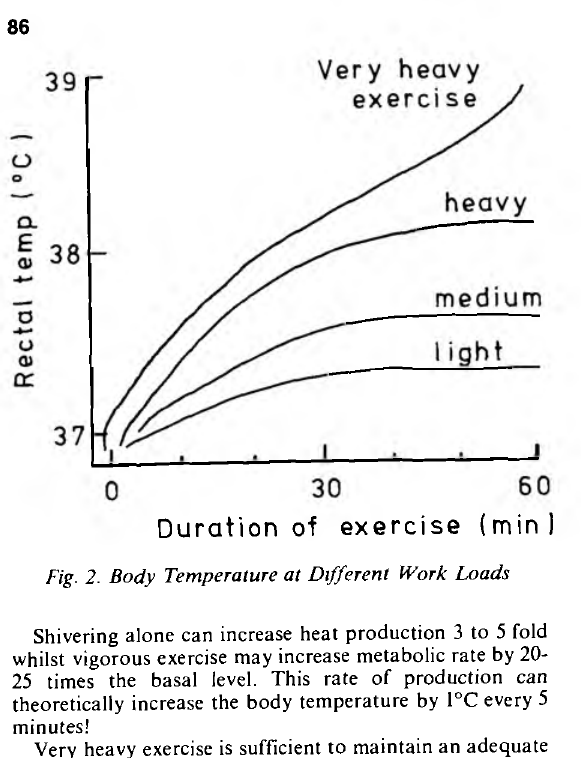
Fig. 2. Body Temperature at Different Work Loads